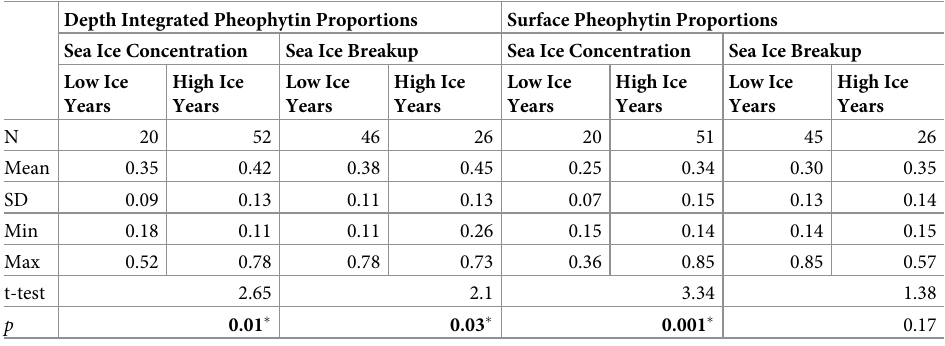
N indicates the number of station year observations that were grouped in each high versus low year bin. The mean, standard deviation (SD), minimum, maximum are provided for the binned pheophytin proportions (Pheophytin/ (Chlorophyll a + Pheophytin)) along with Welch’s t-test and p -value. � Bold values indicate significant differences at p <